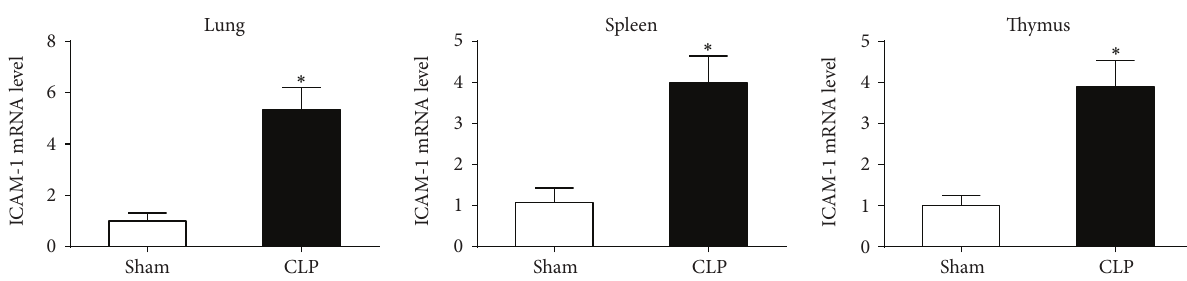
Figure 1: The expression levels of ICAM-1 mRNA were upregulated in lung, thymus, and spleen of CLP mice 24 h after CLP surgery. 𝑛 = 6 per each group. ∗ 𝑃 < 0.01 when septic mice were compared with sham-operated mice. Bars represent the mean ± SD.